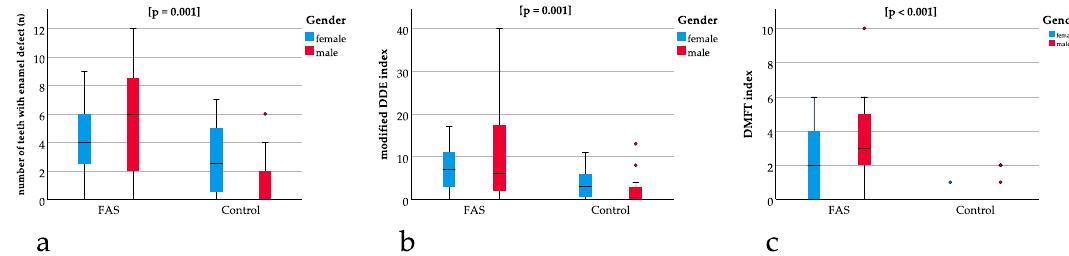
Figure 4. ( a ) Boxplots for significant di ff erences in the number of teeth with enamel defects between the FAS and the control group ( p = 0.001), ( b ) showing significant di ff erences in modified DDE index between the FAS and the control group ( p = 0.001). Comparison between ( a ) and ( b ) underline that enamel defects are not only significantly di ff erent when measured qualitatively (using the DDE index) but also quantitatively (measuring the absolute number of teeth with enamel defects), ( c ) significant di ff erences in the DMFT index between the FAS and the control group ( p <